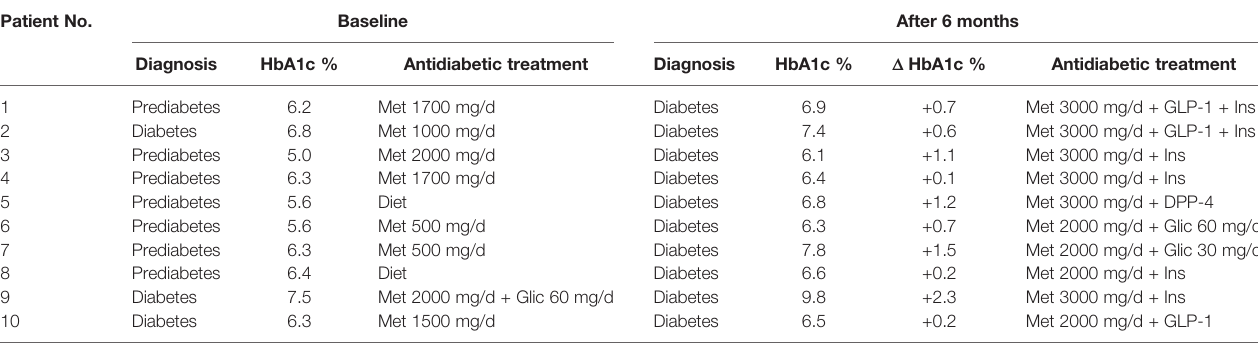
TABLE 2 | Glucose metabolism status and management for 10 individual patients who required more than one antidiabetic drug after 6 months of treatment with pasireotide LAR. Patient No.